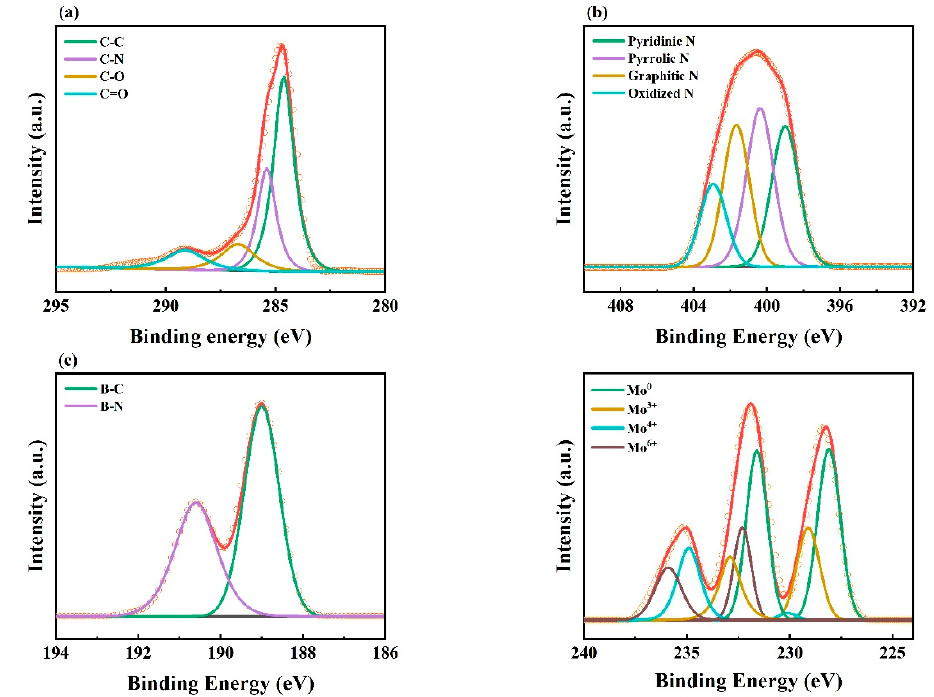
Figure 3. XPS spectra of 800 MoC-BN/C; ( a ) C 1s, ( b ) N 1s, ( c ) B 1s, and ( d ) Mo 3d.